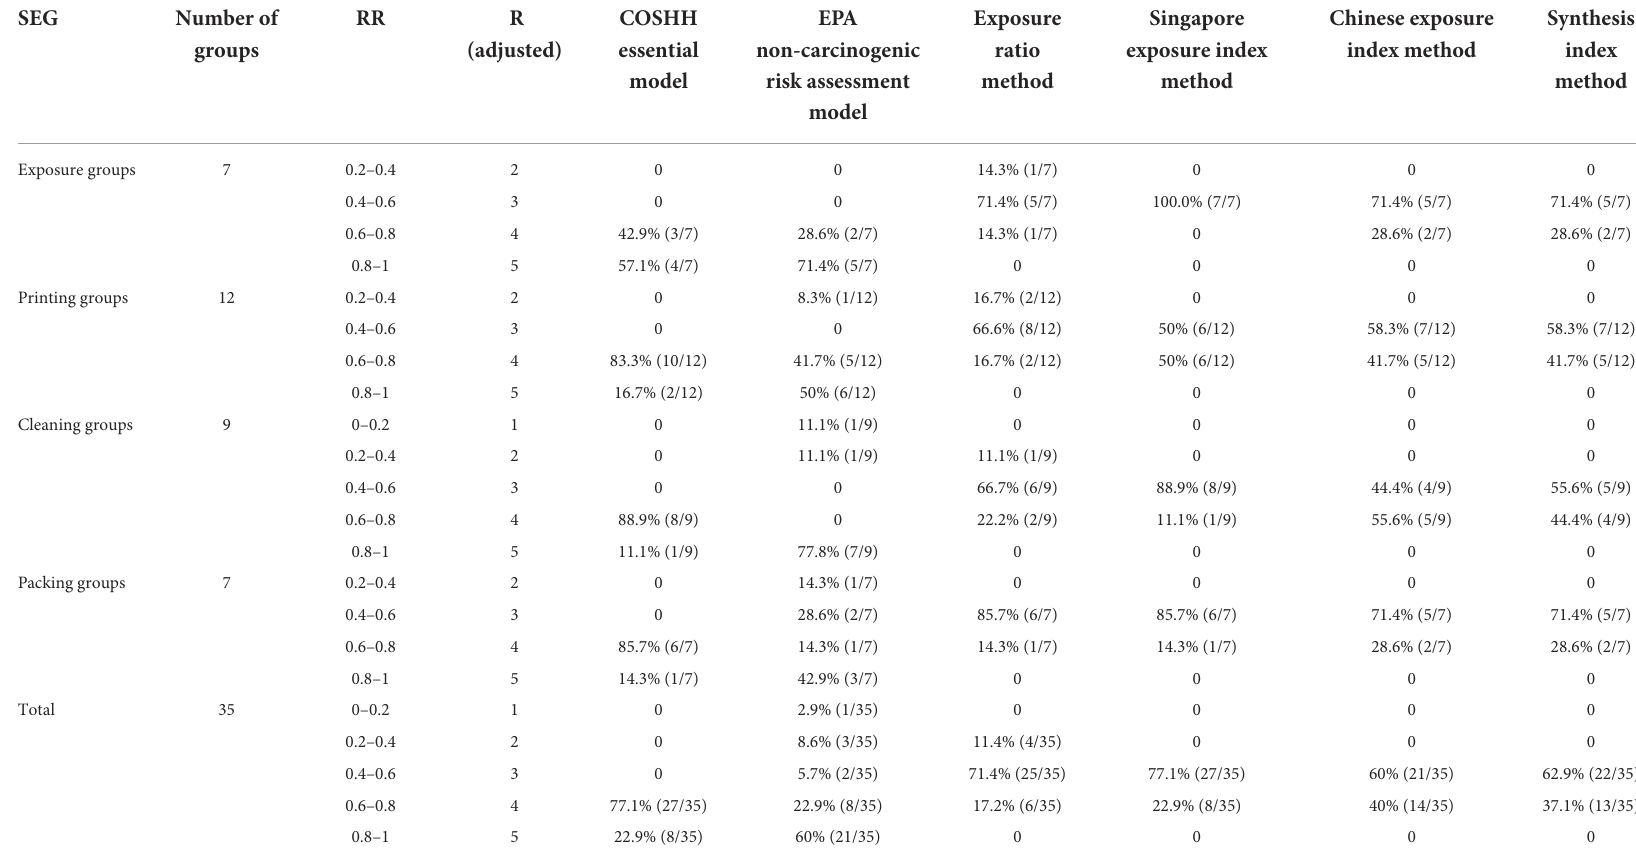
TABLE 4 Risk ratio transformation for risk levels of multiple risk assessment